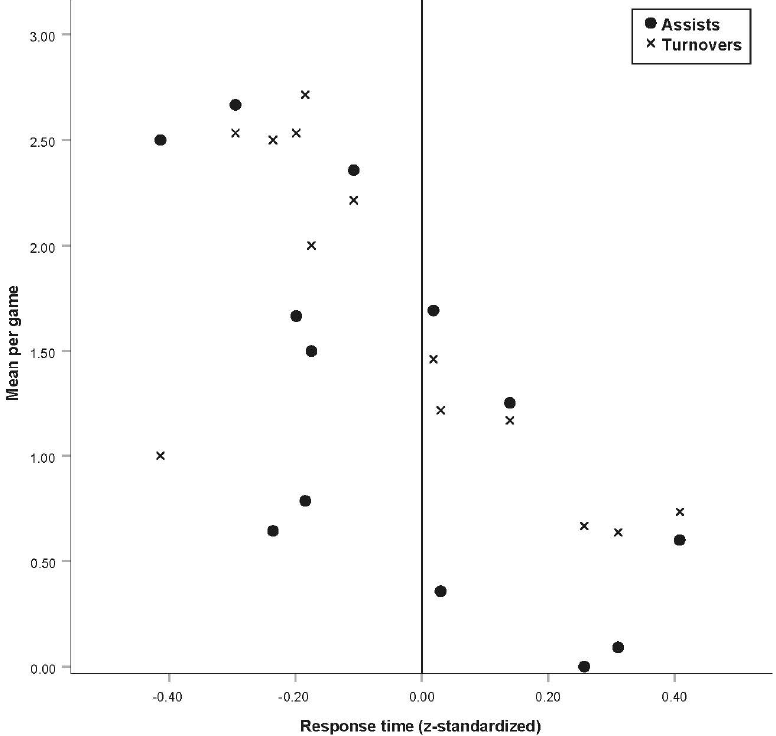
Figure 4. Association between the response time and the performance data. Note. For each player’s response time in the decision-making assessment, his mean assists (circle) and turnovers (cross) per game are